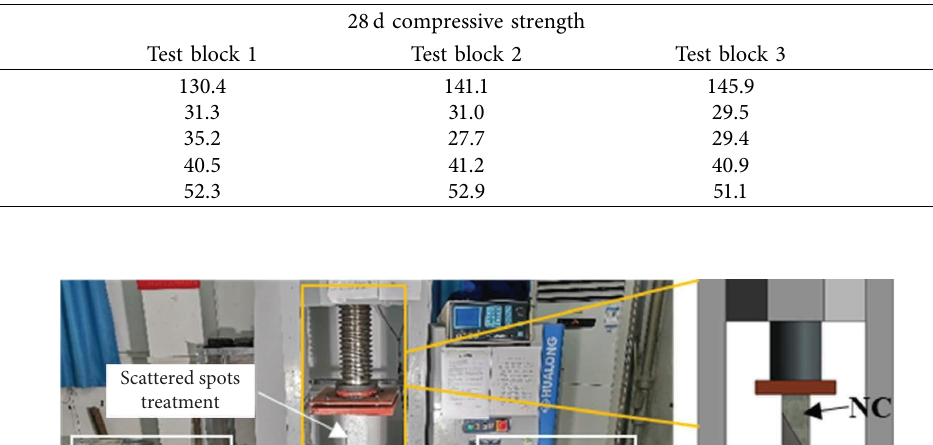
Table 4: Cube compressive strength test results of UHPC and NC (unit: MPa).